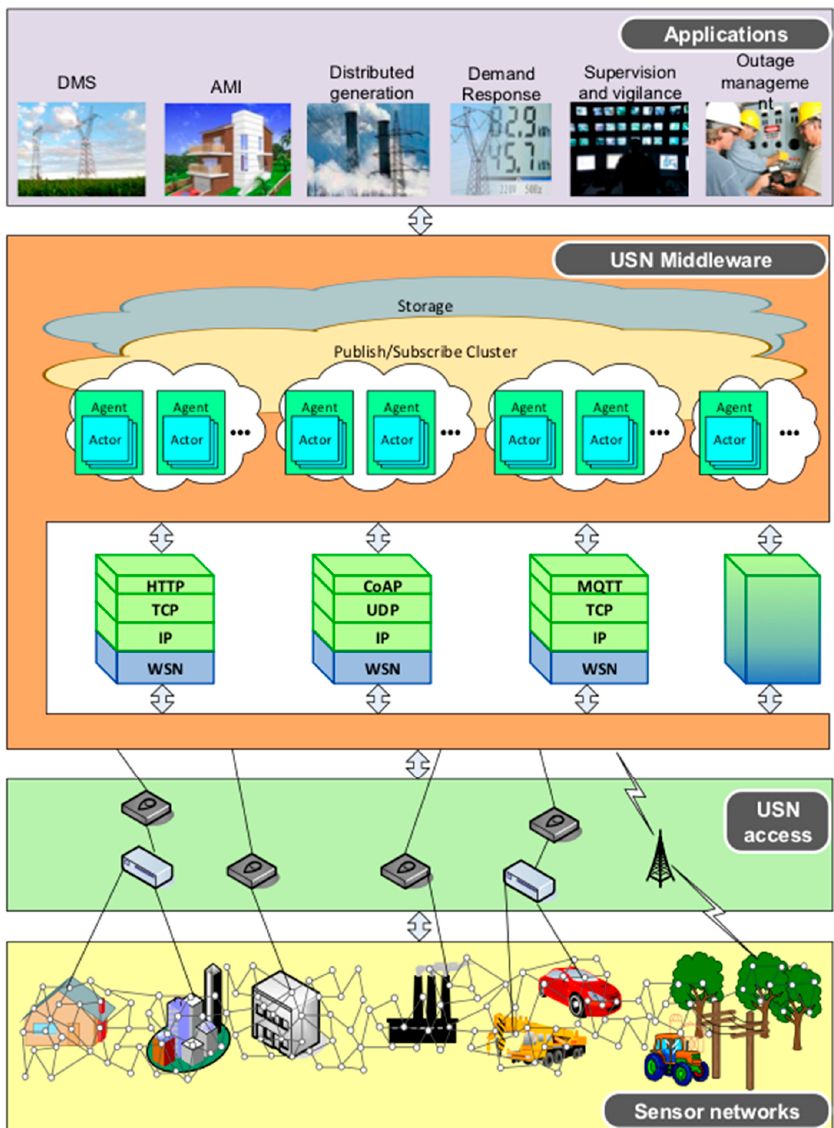
Sensors 2018 , 18 , x FOR PEER REVIEW 13 of 25